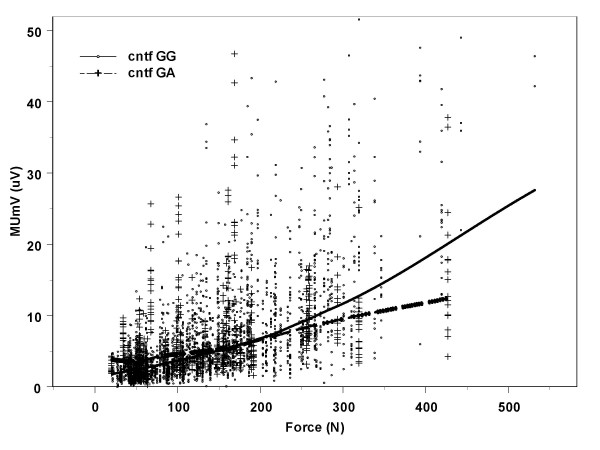
Relationship between knee extension force and average motor unit contribution considering motor unit size and firing rate (MUmV) for CNTF GG and GA genotypes. Data represent individual measurements with a loess regression line for each genotype. Statistical analyses are given in Table 3.